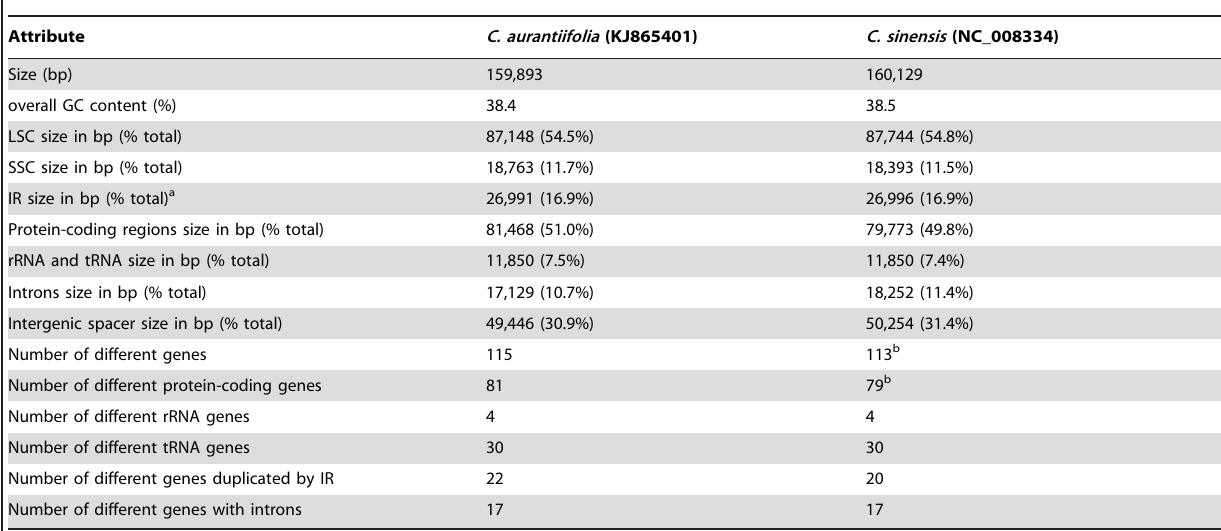
Table 1. Summary of the Citrus chloroplast genome